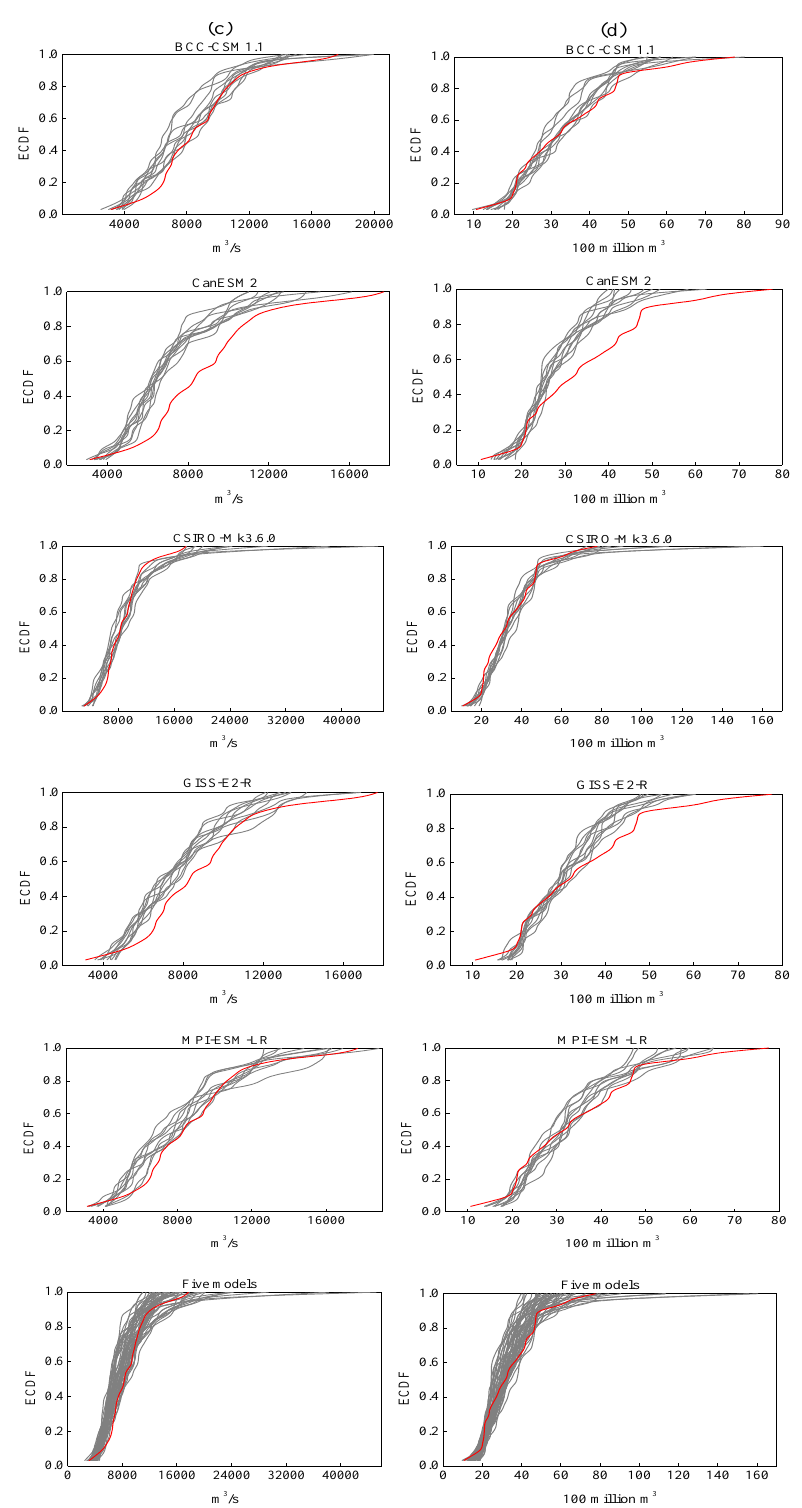
Figure 3. ECDFs for precipitation and floods during the period 1970–2000: (a) observed and downscaled AMX1p, (b) observed and down- scaled AMX7p, (c) observed and simulated AMX1d, and (d) observed and simulated AMX7fv. Red line represents the observed. Grey lines represent model